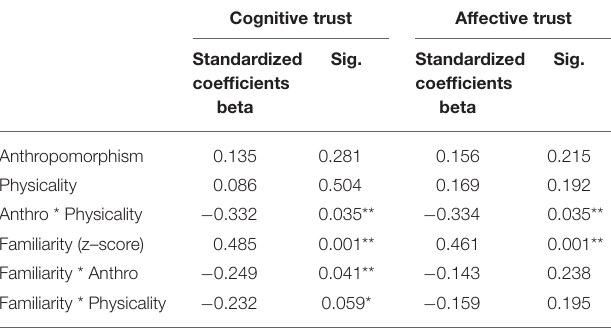
TABLE 3 | Moderated regression with the dependent variables of affective and cognitive trust. Cognitive trust